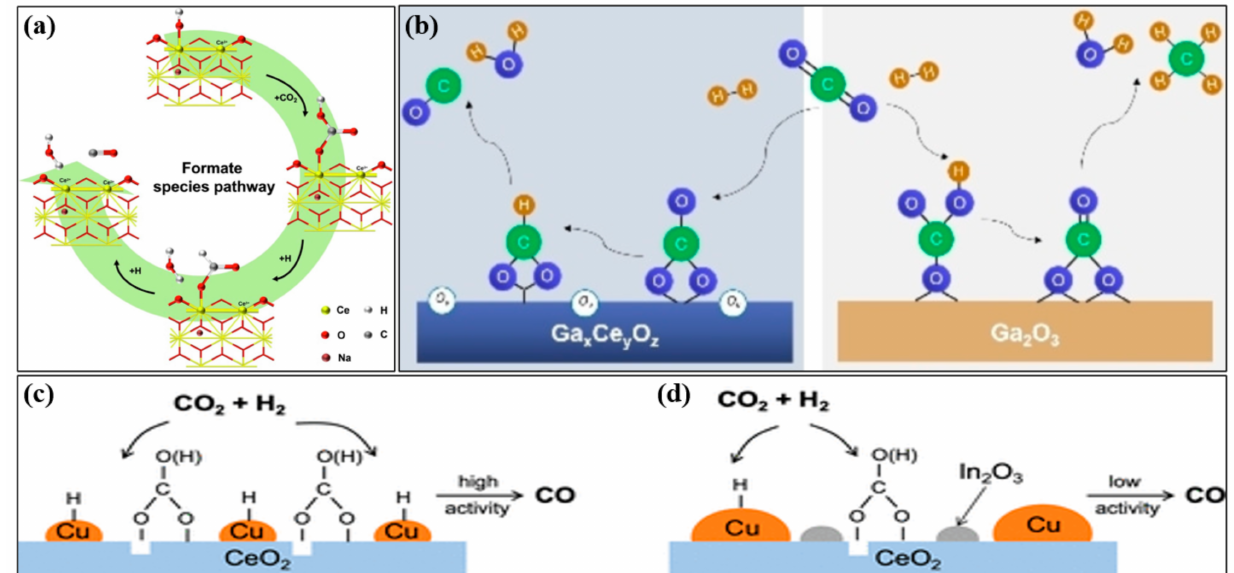
Figure 4. The associative mechanism of the RWGS reaction over ( a ) LN-CeO 2 , reprinted with permission from [86]. Copyright Elsevier, 2022, ( b ) Ga 2 O 3 − CeO 2 , reprinted with permission from [90]. Copyright Wiley, 2022, ( c ) Cu-CeO 2 , reprinted with permission from [91]. Copyright ACS, 2022, ( d ) Cu5In5-CeO 2 , reprinted with permission from [91]. Copyright ACS,